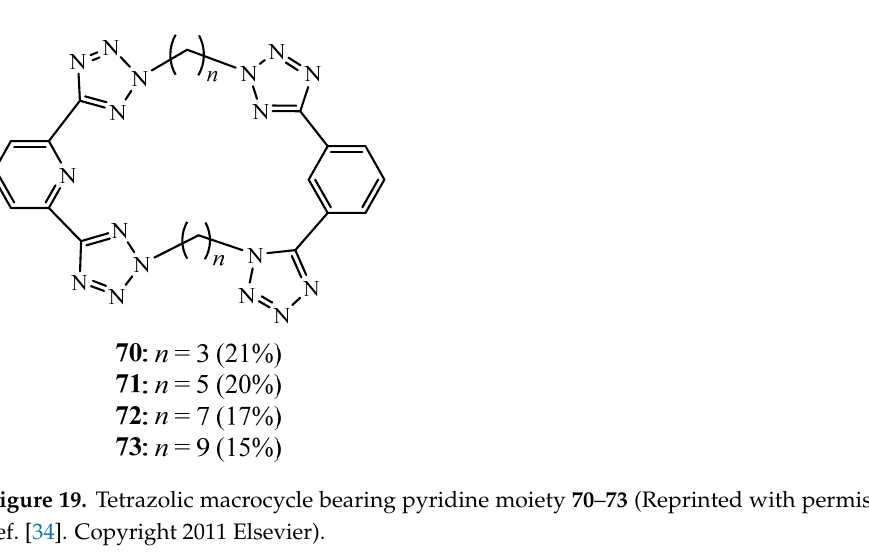
10 of 26 Figure 18. Tetrazolic macrocycles 66 − 69. (Reprinted with permission from ref. [33]. Copyright 2009 Elsevier).